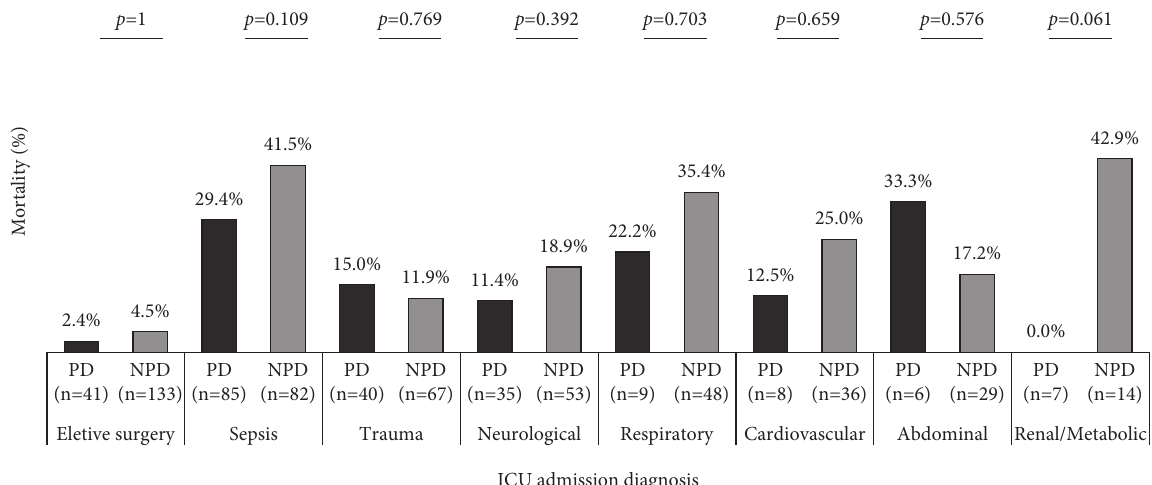
Figure 3: Comparison of mortality rates between patients with and without Parkinson’s disease (PD and NPD groups, respectively) according to the reason for admission to the intensive care unit (ICU). The results are presented in percentages of deaths considering the total number of patients admitted according to the reason for ICU admission stratified by the group. The p values > 0.006 refer the significance adjusted of the chi-square test result. n , total number of patients in each group categorized by reason for ICU